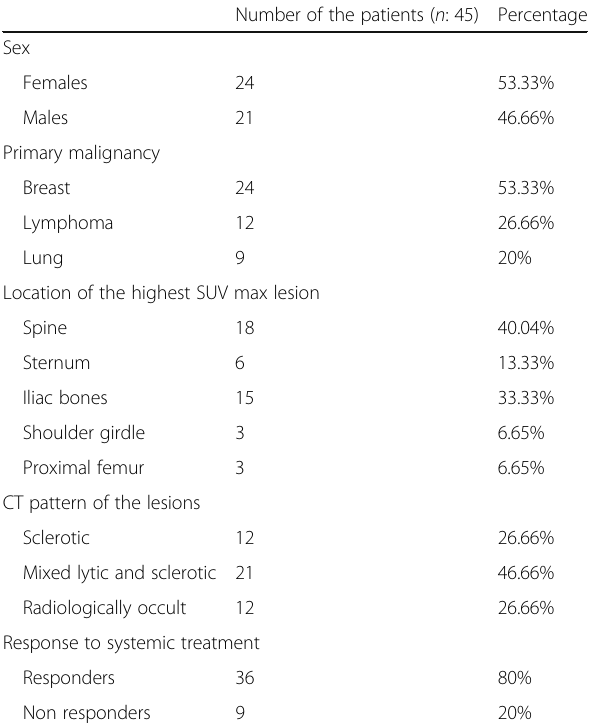
Table 1 Distribution of the studied patients according to different